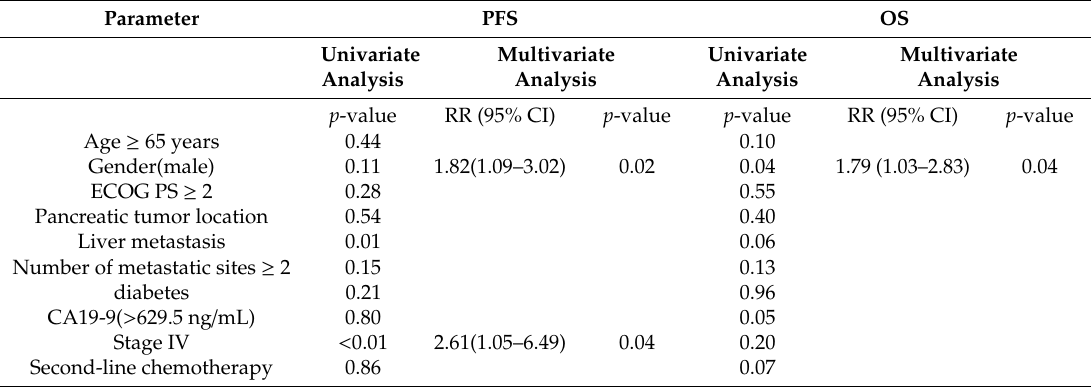
Table 3. Results of univariate and multivariate analyses of prognostic factors for first-line PFS and OS in all eligible patients with unresectable pancreatic